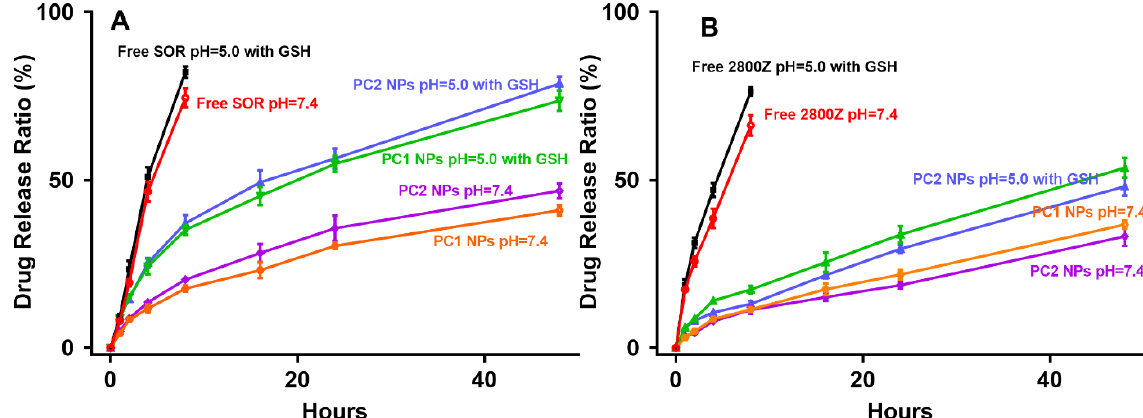
Figure 3. Drug release rates of sorafenib (SOR) and 2800Z from free drug, S2@PsPC1 NPs (PC1),